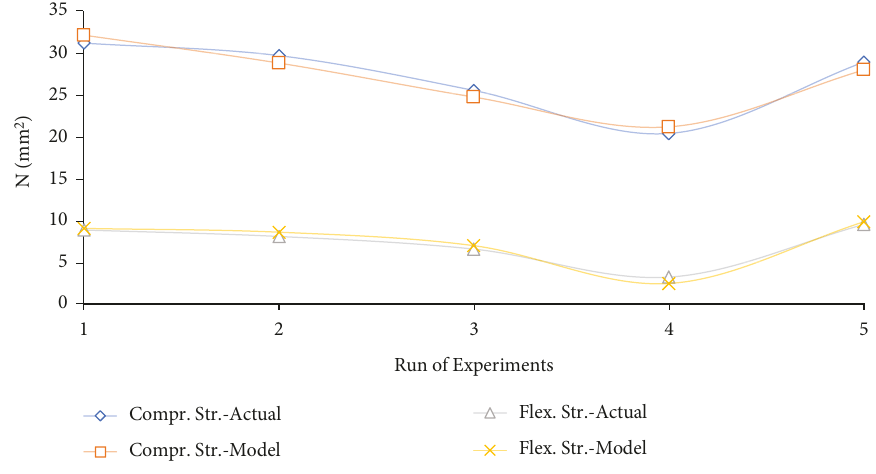
Figure 19: Actual vs. EVD model predicted responses. Table 18: R -sqd. calculations for flexural strength response. Std.